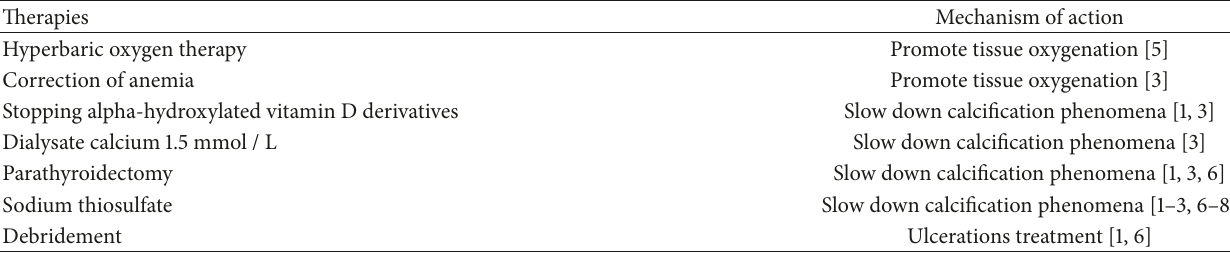
Table 1: Therapies that have been suggested to improve calciphylaxis and their mechanism of